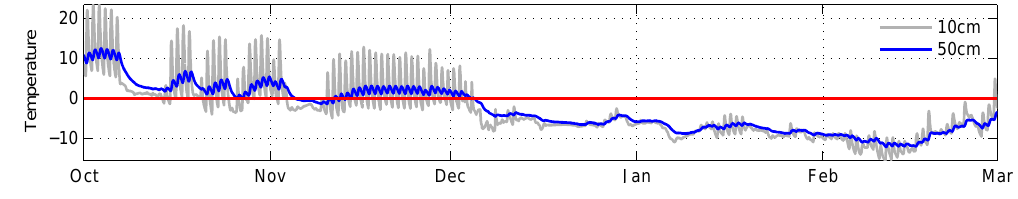
Fig. 10. Rock temperatures measured at M1.